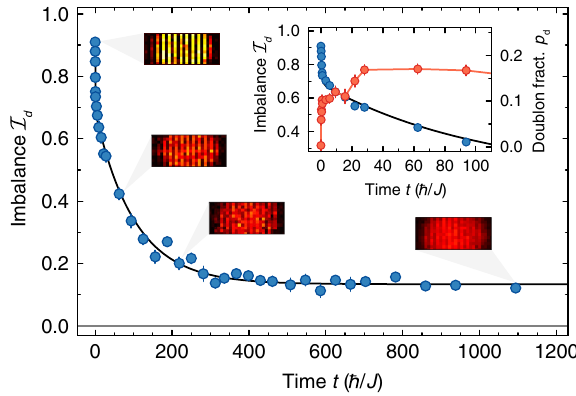
FIG. 2. Dynamics of the dirty component alone. Evolution of the imbalance I d (points) for a system composed only of the dirty component j d i . The blue points show the measured data and the solid line a fit of the points to the sum of two exponentials including an offset. The imbalance decreases monotonically, albeit on distinct timescales. An initial decay, where interactions are negligible, is followed by a slower second timescale governed by doublon relaxation. After approximately 300 τ , a quasisteady state of finite imbalance I d ≈ 0 . 13 is reached. The four rectan- gular boxes show the averaged density distribution in the trap center (black-red-yellow color scale) at times 0 τ , 63 τ , 219 τ , and 1094 τ , displaying the reduction in the imbalance. In the inset, we show the short-time dynamics of the imbalance I d (blue) and the doublon population p (red) defined as the fraction of atoms in d doubly occupied lattice sites. Notably, the doublon formation rate changes markedly between the two dynamical regimes of the imbalance decay. The error bars represent 1 standard deviation of the